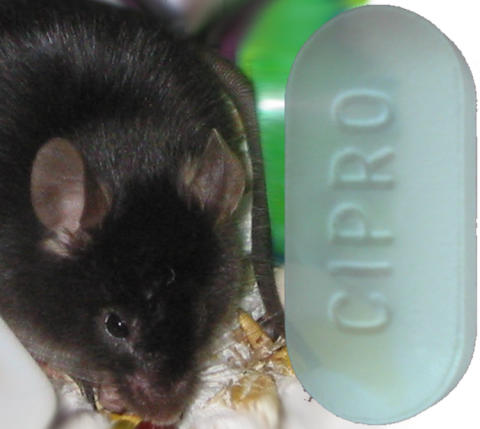
Inhibiting a protein involved in DNA repair in bacteria might prevent mutations that promote antibiotic resistance, prolonging the effectiveness of ciprofloxacin and other quinolone antibiotics